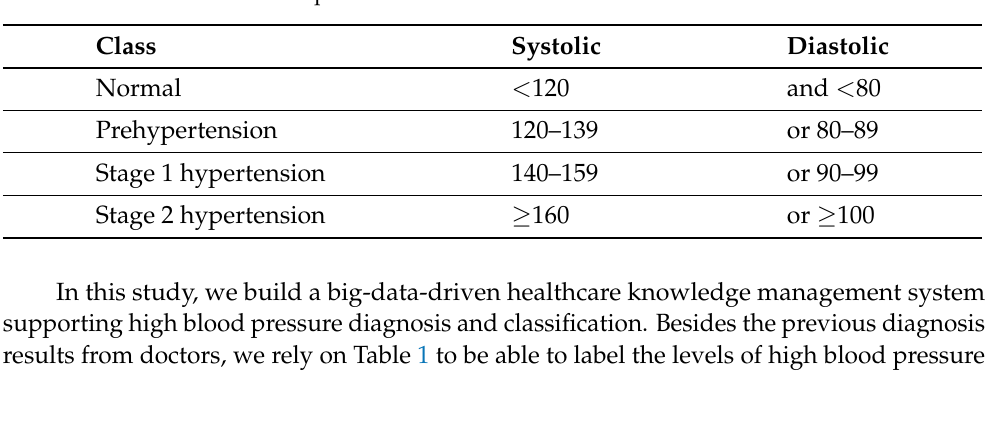
Table 1. Classification of blood pressure for